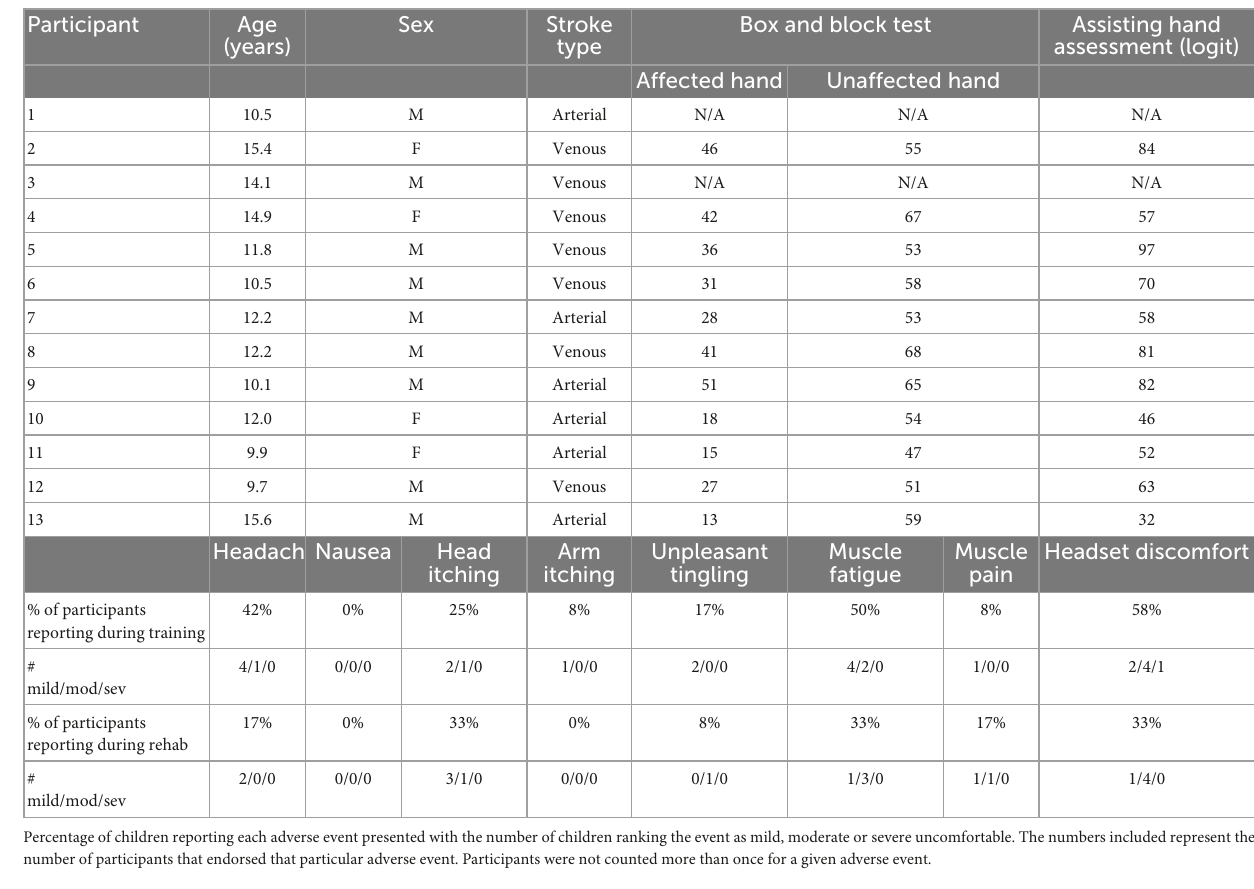
TABLE 1 Participant demographics and reporting of adverse events.